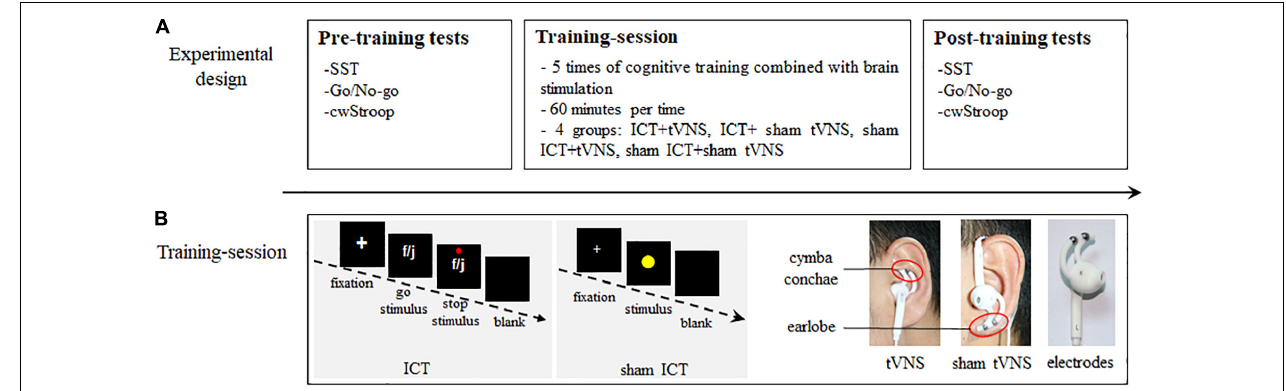
FIGURE 1 | Research schedule. (A) Experimental design: the three sessions of pre- and post-training tests and training-session. (B) Training-session: (1) The SST framework in ICT; (2) The SRT framework in sham ICT; (3) Position of tVNS on the cymba conche of the left ear; (4) Position of sham tVNS on the earlobe of the left ear; (5) The Ag/AgCl